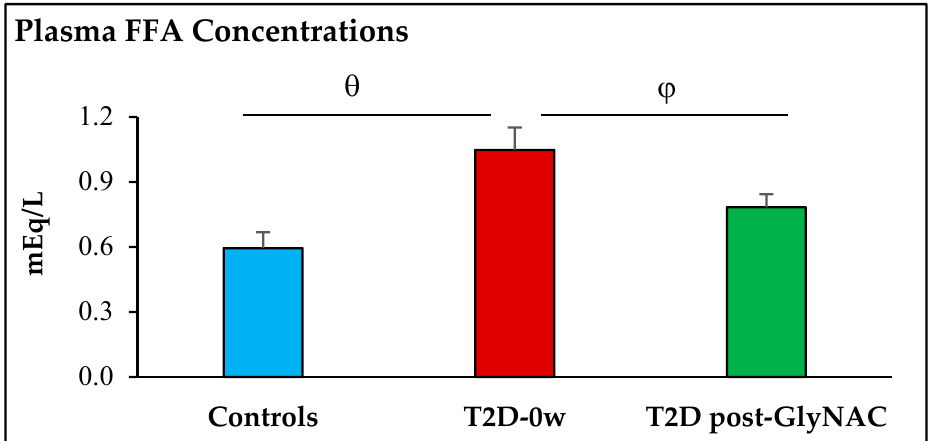
Figure 3. GlyNAC supplementation lowers plasma free ‐ fatty acid concentrations in Type 2 diabetes. FFA = free fatty acids; T2D ‐ 0w = participants with Type 2 diabetes before GlyNAC supplementation; T2D post ‐ GlyNAC: participants with T2D participants 2 weeks after GlyNAC supplementation. φ = p < 0.01; θ = p < 0.05.